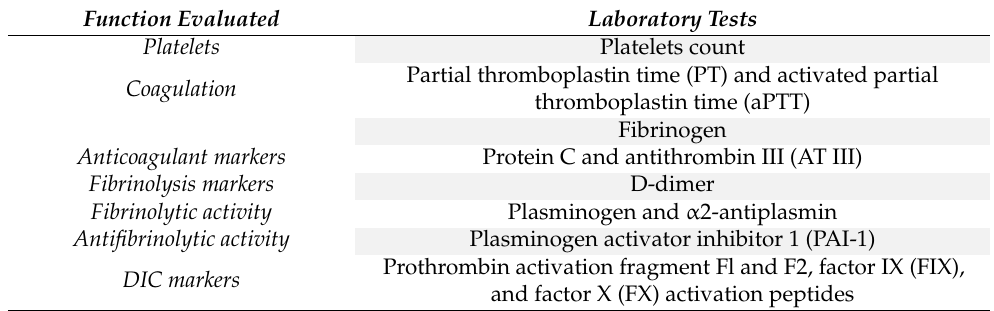
Table 2. Coagulation laboratory